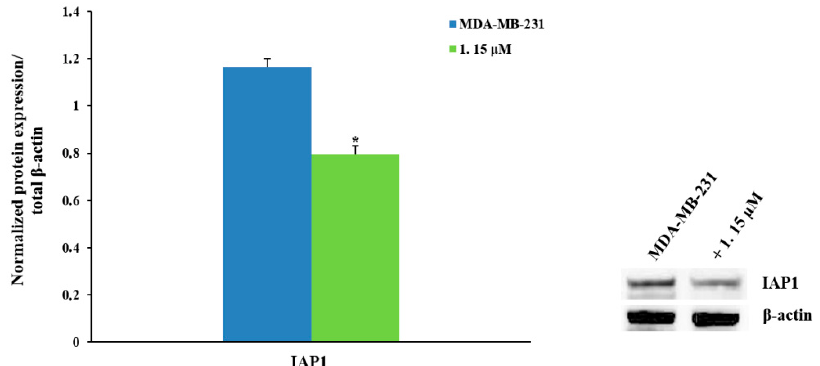
Figure 8. Western blot analysis of the levels of Survivin and Bcl-2 in SUM 149 cells treated for 24 h with Compound 3 . On the left the results are expressed as mean ± standard error (SE) of two different experiments; on the right, the results of a representative experiment. * Differences when treatments are compared to the control, p < 0.01.